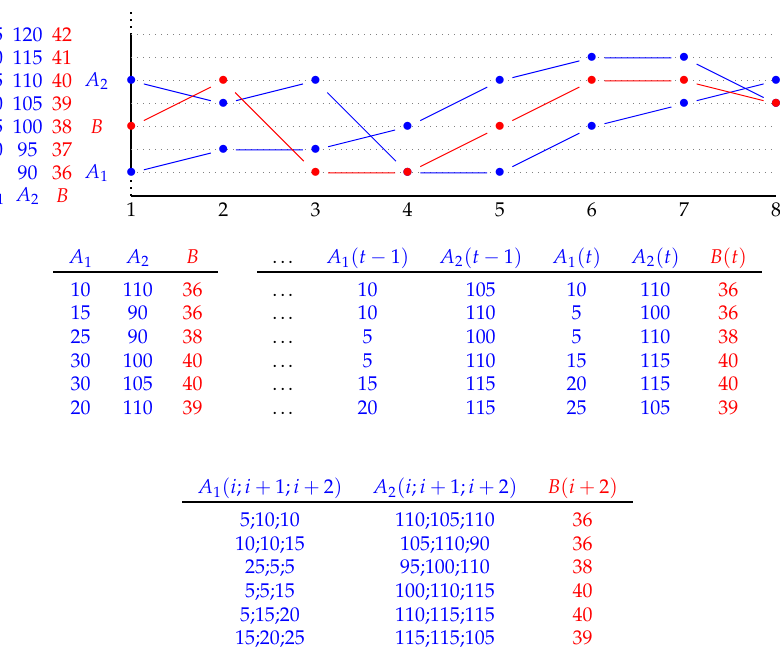
Figure 1. A multivariate time series with three variables ( top ). Static regression ( middle, left ). Static lagged regression ( middle, right ). Multivariate time series regression ( bottom